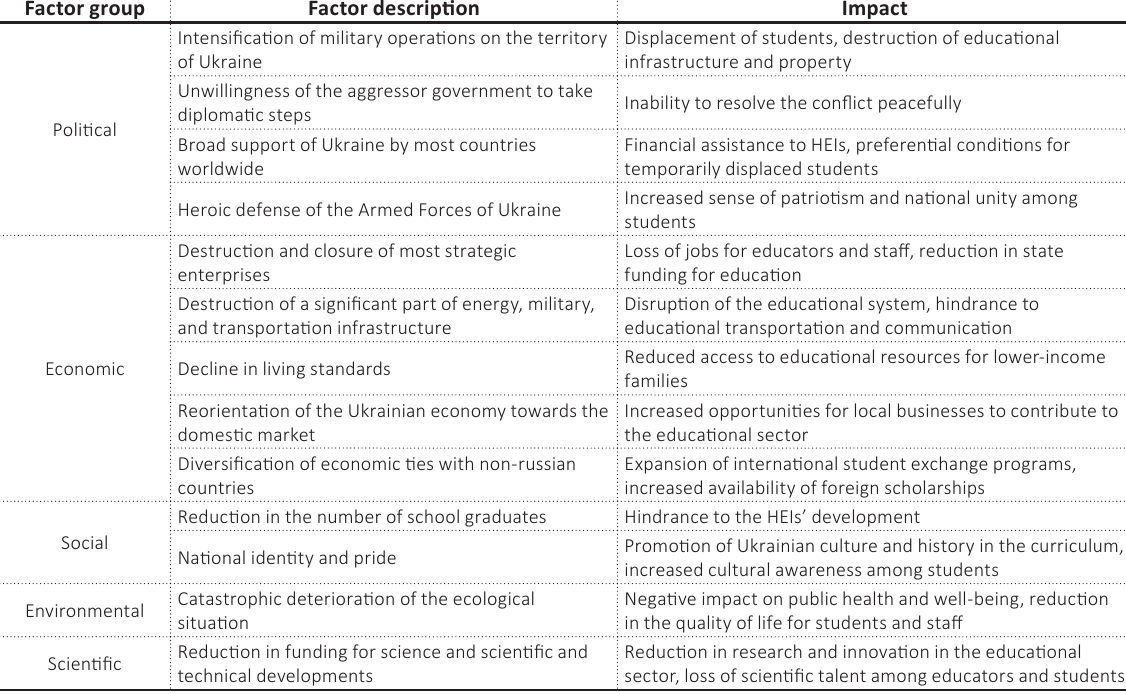
Source: Own elaboration.